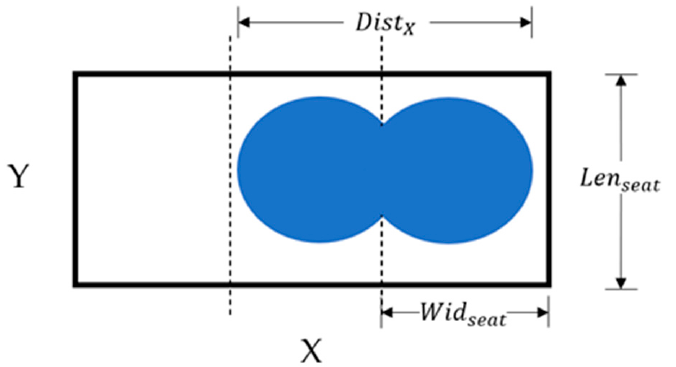
Figure 8. The top view of the Figure 6c case. The three rectangles divided by the dotted line are the top view of the three seats. The blue point cloud indicates two passengers that are clustered into one class.